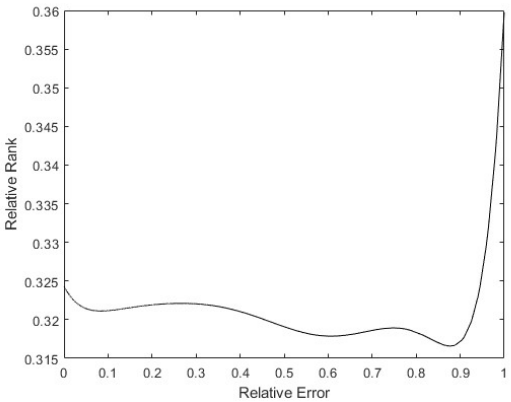
Figure 39. Polynomial regression of relative rank to relative error on X 4 .